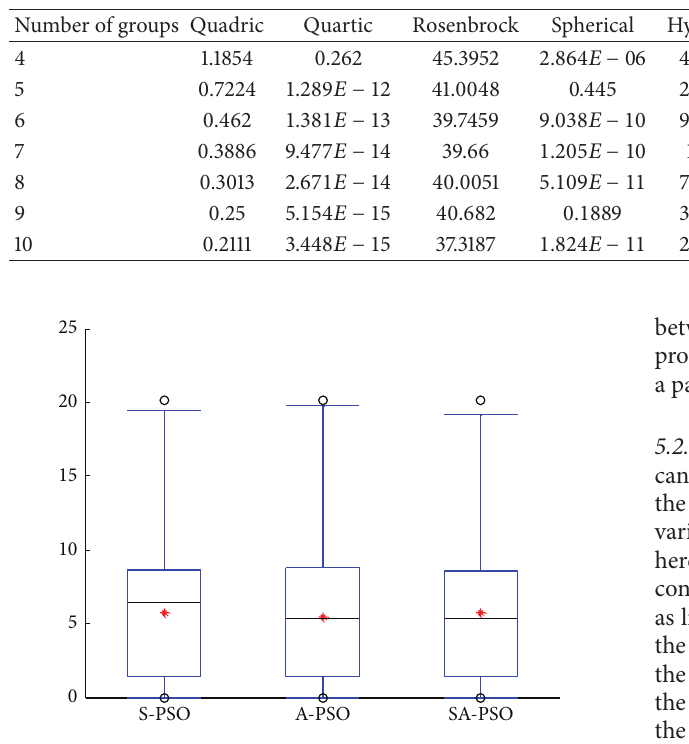
Figure 6: Results of experiments on parameter estimation for FM sound